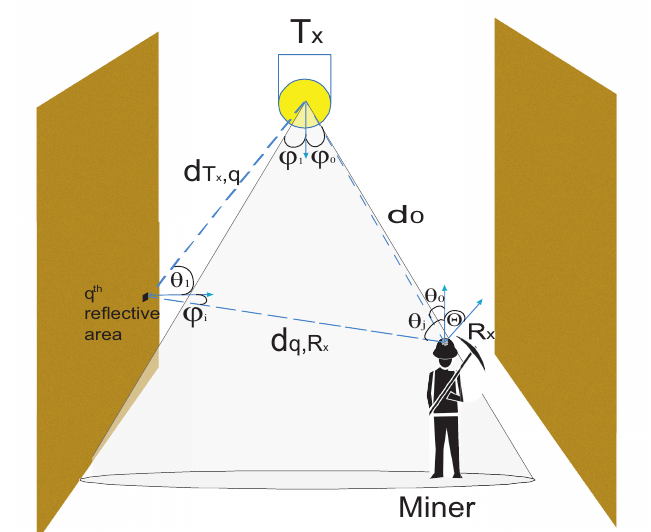
Figure 2. Geometry of the LoS and NLos propagation